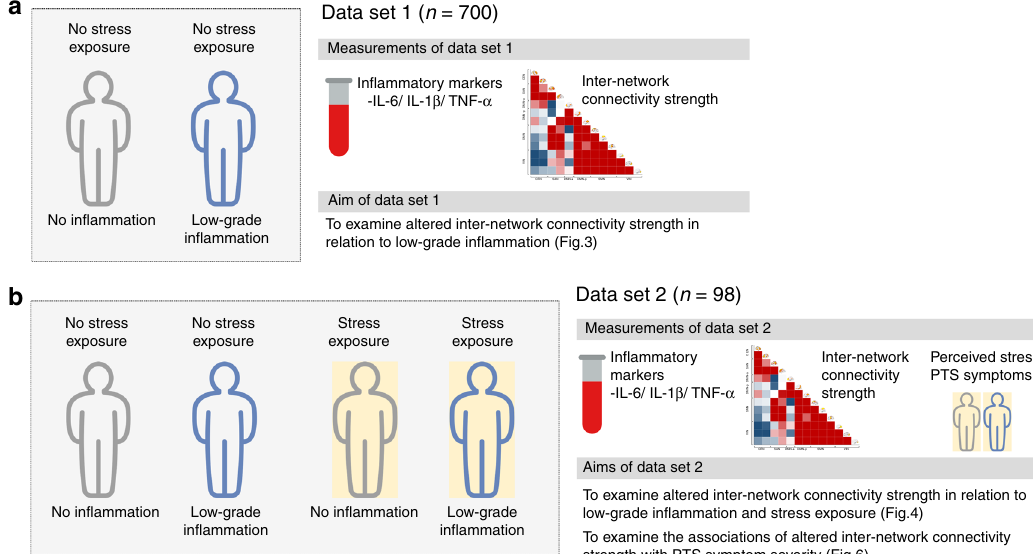
To examine altered inter-network connectivity strength in relation to low-grade inflammation and stress exposure (Fig.4) To examine the associations of altered inter-network connectivity strength with PTS symptom severity Fig. 1 A brief description on the data sets. Two large independent data sets were used in this study. a Seven hundred adults in data set 1 were categorized into one of two groups based on serum levels of IL-6, IL-1 β , and TNF- α . This was used to determine whether inter-network connectivity strength may be altered in relation to low-grade in fl ammation. b Data set 2 included 52 subjects with repeated exposure to traumatic events and 46 demographically matched healthy individuals without having been exposed to any traumatic event, and were further categorized according to their levels of low-grade in fl ammation. Alterations in inter-network connectivity strength in relation to both conditions of low-grade in fl ammation and stress exposure were examined using data set 2 shown in panel b . Furthermore, data from the stress-exposed group ( n = 52) of data set 2 were also used to examine whether alteration in inter-network connectivity strength may contribute to PTS symptom severity. IL-6 interleukin-6, IL-1 β interleukin-1 β , TNF- α tumor necrosis factor- α , PTS posttraumatic stress.